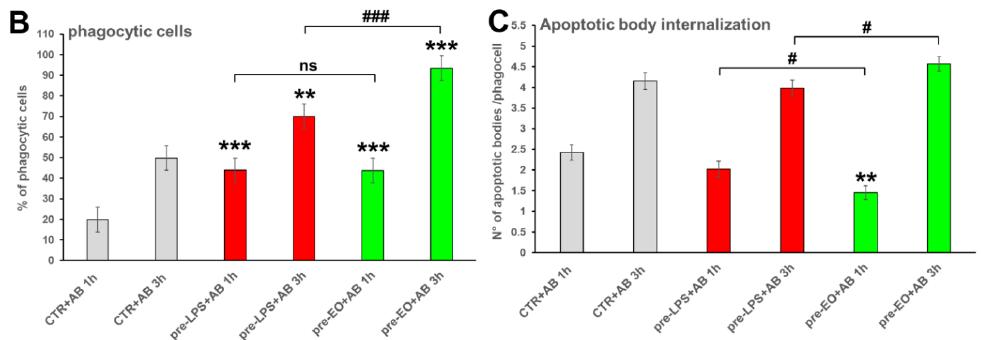
Figure 4. Effects of Eucalyptus oil treatment on MDM phagocytic ability against apoptotic bodies from the MCF7 human breast cancer cells. Apoptotic bodies (AB) were obtained from MCF7 breast carcinoma cells as described in Materials and Methods. The phagocytic activity of MDMs pre-treated for 24 h with 0.008% EO and of untreated controls was tested by adding to cell cultures the PI-stained apoptotic bodies (AB; red hue) in a ratio of about 5 AB/cell. MDMs pre-treated for 6 h with 0.1 µg/mL LPS were used as a positive control of macrophage activation. Samples were analyzed 1 h and 3 h after AB administration. ( A ) Confocal microscopy images, showing the AB uptake in untreated control and EO treated MDMs. Merged images with differential interference contrast, used to visualize cell morphology, are shown. Arrows point to internalized AB. Bar = 50 µm. ( B , C ) Quantitative assessment of MDM phagocytic activity obtained by counting the number of phagocytes, reported as percent of phagocytic cells ( B ), as well as the number of AB per cell ( C ). A minimum of 200 cells/sample were analyzed and the results are the mean ± SD from three independent experiments ( n = 3). Significance (One-way ANOVA + Tukey multiple comparison test), * vs. CTR at the same time: ** p < 0.01, *** p < 0.001; # vs. LPS: # p < 0.05, ### p < 0.001; ns: not significant.